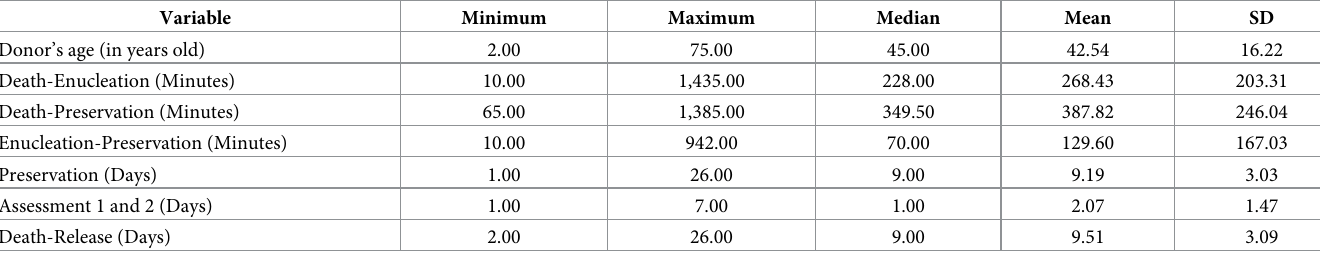
Table 2. Chronological variables of the cornea donation process. Brazil, 2020 (n = 419).